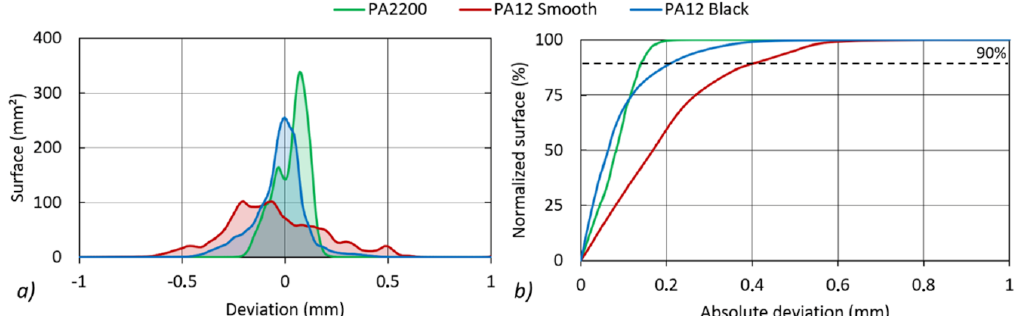
Actual / nominal analysis: ( a ) histograms of geometry deviations, ( b ) cumulative Figure 9. Actual/nominal analysis: ( a ) histograms of geometry deviations, ( b ) cumulative deviation deviation histogram.